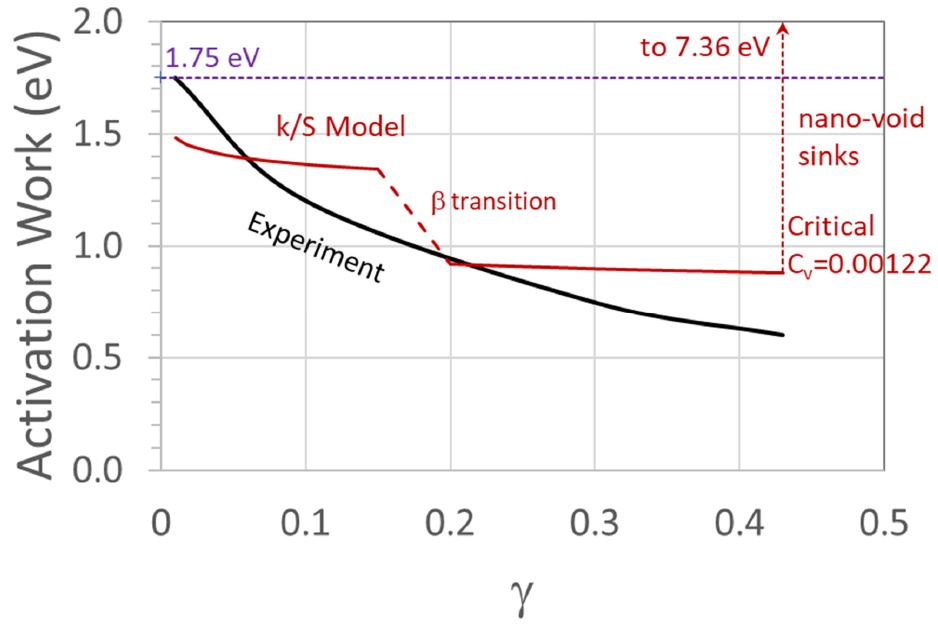
Figure 11. Activation work versus shear strain determined from the Haasen plot tangent (“Experi- ment”) to demonstrate the data trend compared to the “k/S Model” values obtained by subtracting G osmotic = kT ln (C V /C 0 ) from 1.75 eV. The abrupt increase in activation work to 7.36 eV occurs at C V = 1.22 × 10 − 3 .